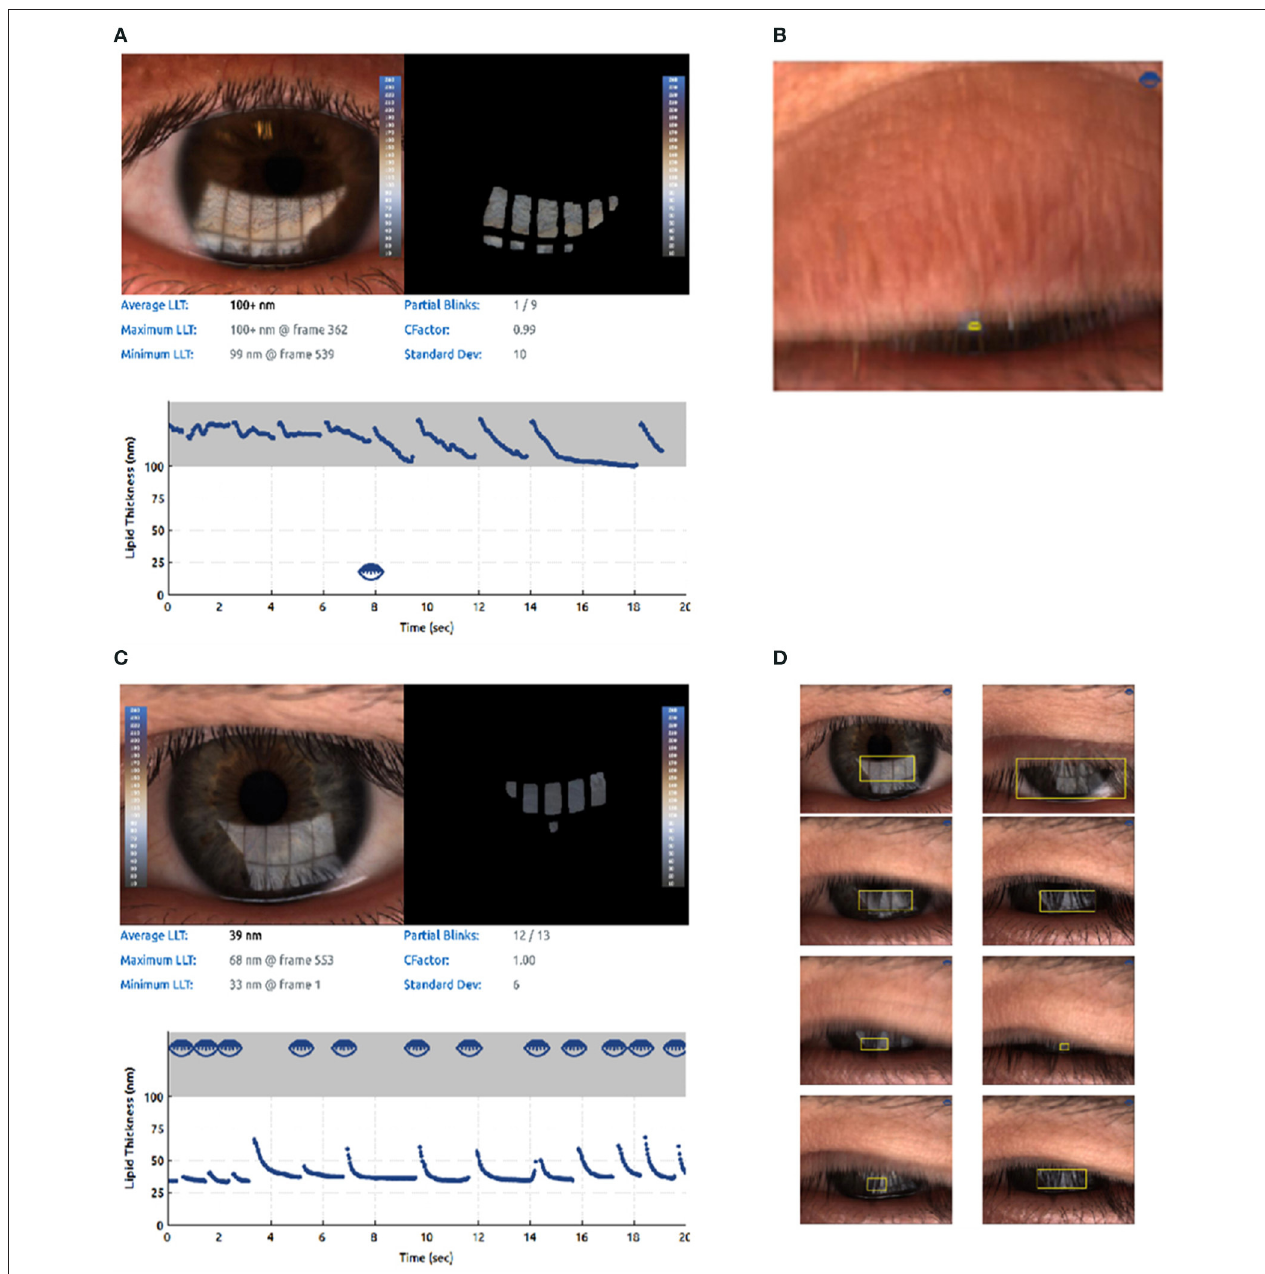
FIGURE 4 | Lipid imagine report and incomplete blinking (an example from LipiView II ocular surface interferometer). The computer system captures a video image file that is recorded over time since the interference pattern changes as the tear film is distributed across the cornea during blinking. (A) Lipid imagine report and incomplete blinking. (B) Partial blink imagines. (C) Another for lipid imagine report and incomplete blinking. (D) Another for partial blink